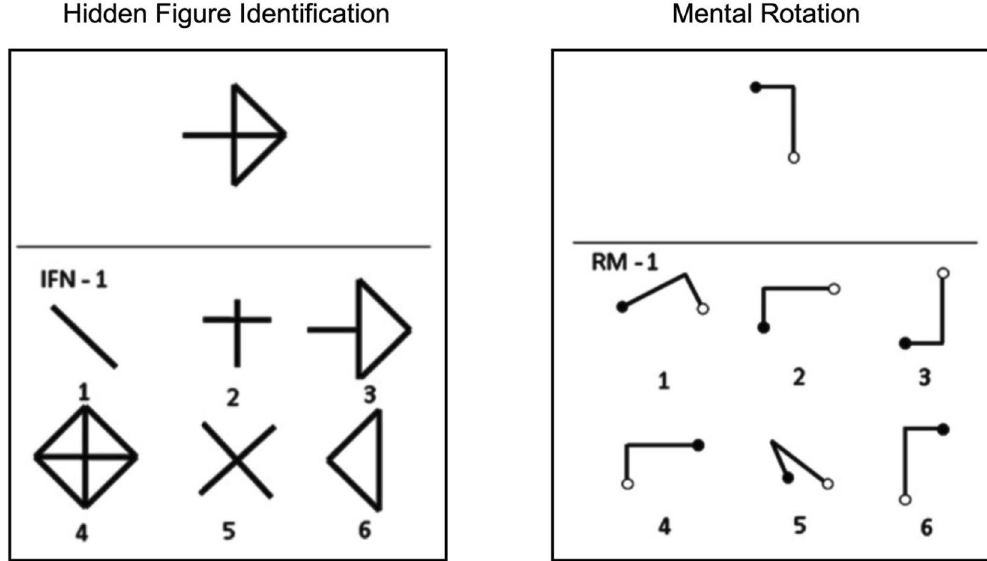
Figure 1. Examples of items from Hidden Figure Identification and Mental Rotation tasks. In the Hidden Figure Identification task, participants have to identify among the options a simple shape which is contained within the target stimulus (here, the correct response is the option 3). In the Mental Rotation task, participants are required to identify among the options the one matching the target stimulus after a mental rotation on the horizontal plane (here, the correct response is the option